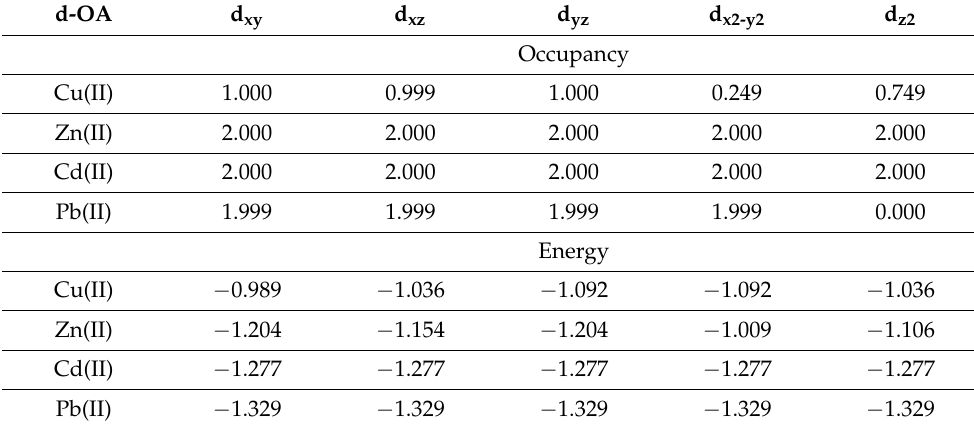
Table 10. d-atomic orbital (d-OA) occupancies (in e) for metal ions. d-OA d